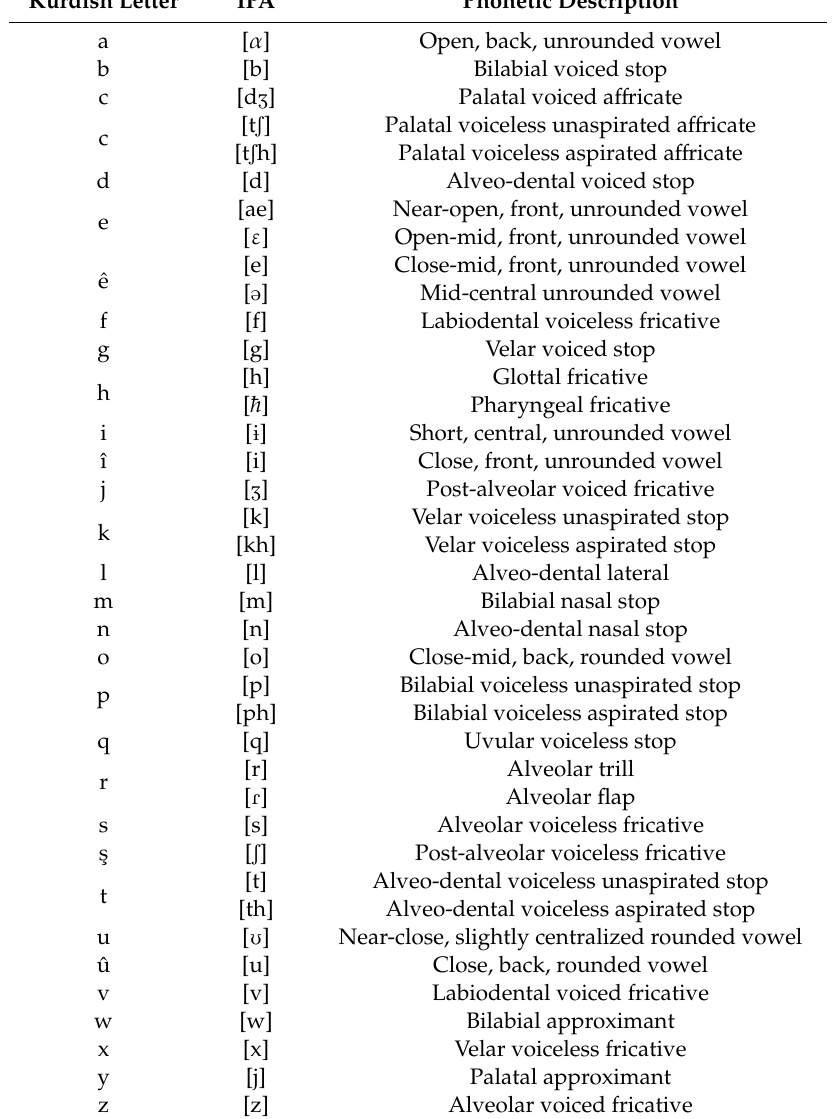
Table 1. Phonemes of the Kurdish language [35–37].